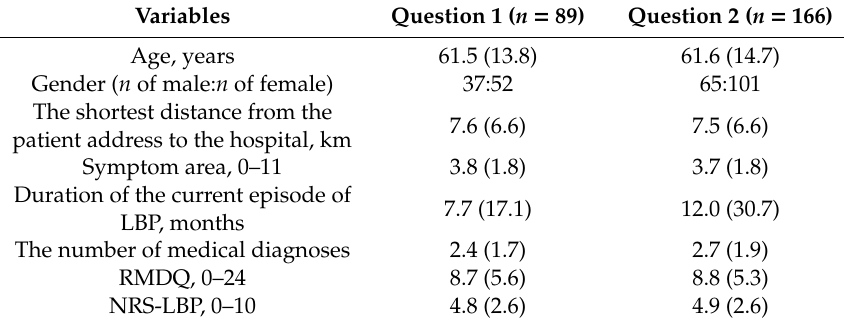
Table 1. Characteristics of the participants.